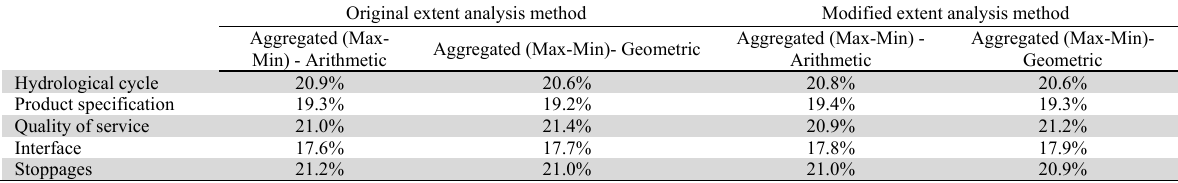
Final weights of risk events using FAHP aggregation methods